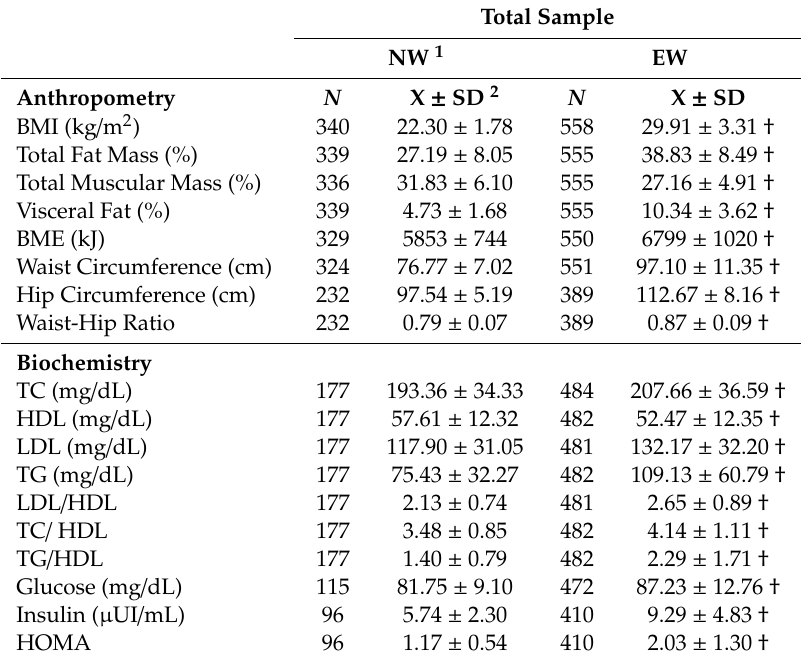
Table A1. Anthropometric and biochemical data distributed according to nutritional state (total sample).